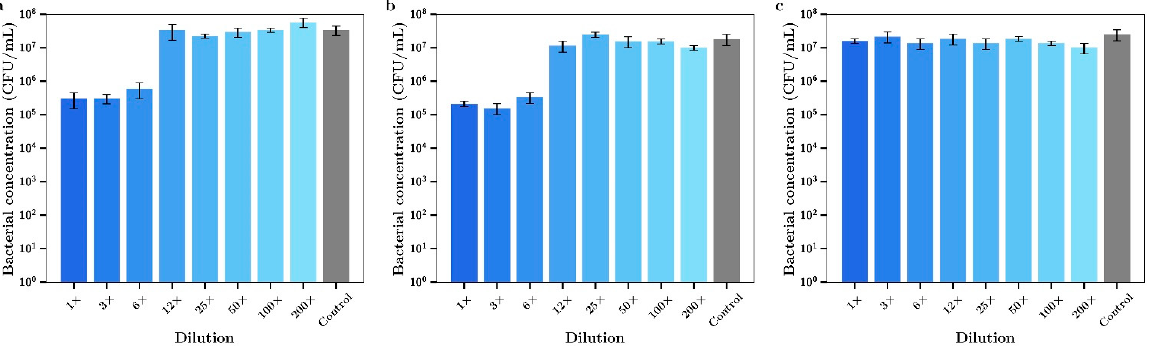
Figure 13. Bacterial concentrations of P. aeruginosa incubated in various dilutions of the 7-day incubation release media of bone cement containing ( a ) Ag, ( b ) Ag + vancomycin, ( c ) vancomycin. (Silver loaded at 0.8% and vancomycin at 0.8% w/w ) ( n = 3).